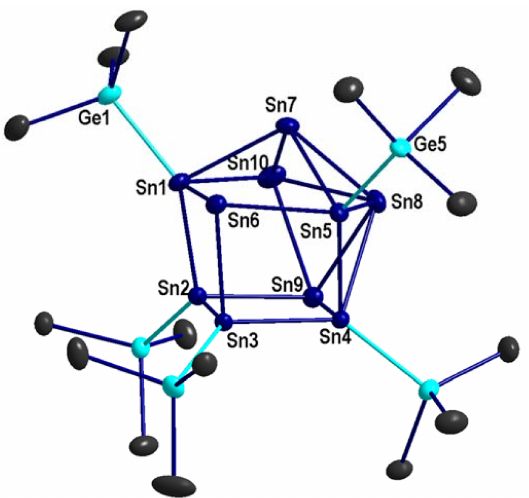
Figure 3. Molecular structure of the anionic metalloid cluster {Sn 10 [Ge(SiMe 3 ) 3 ] 5 } − , without CH 3 groups (displacement ellipsoids with 50% probability). Selected bond lengths [pm] and angles [ ◦ ]: